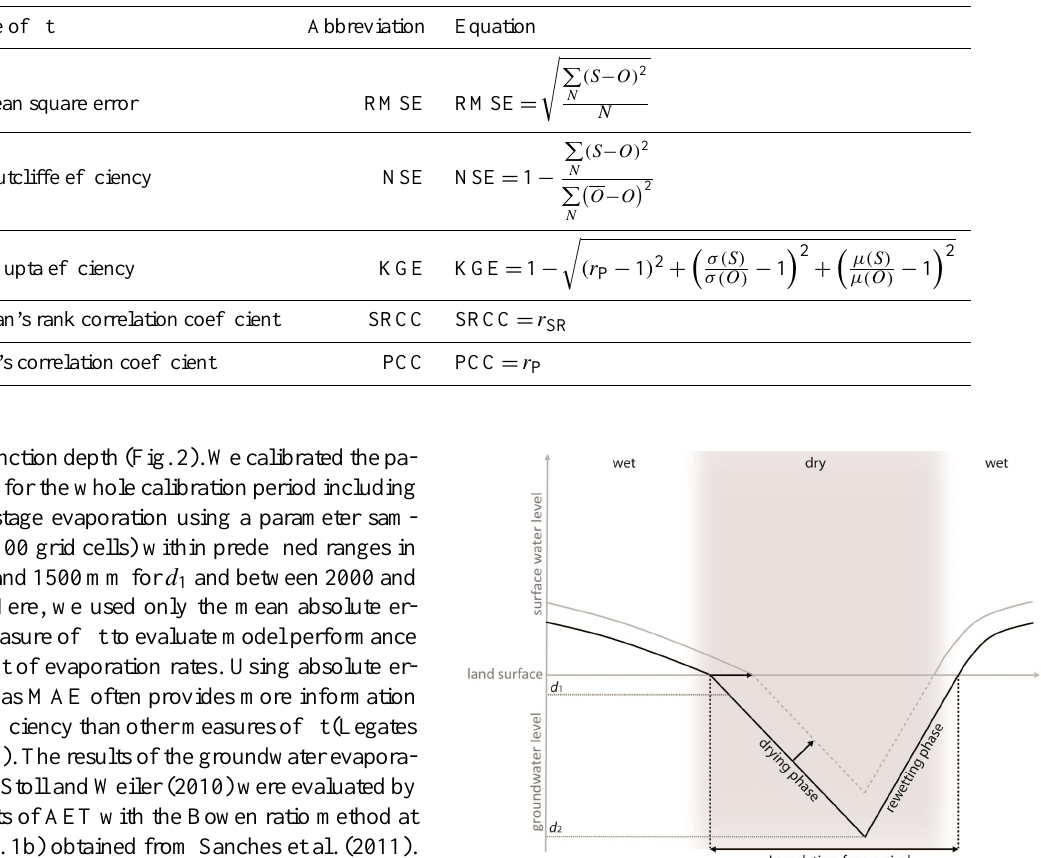
Table 2. Measures of fit with their abbreviations and equations ( N : number of time steps, S : simulated, O : observed, σ(x) : standard deviation of x , µ(x) : mean of x ).